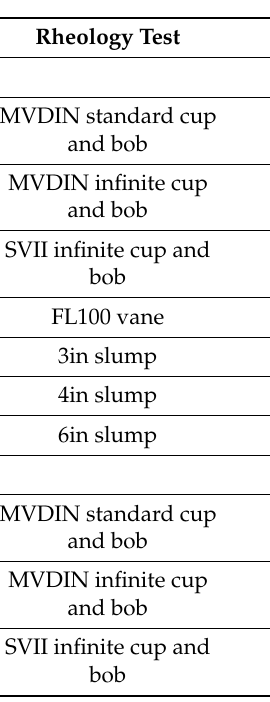
Table 9. Statistical analysis of rheology tests against loop test experiment for